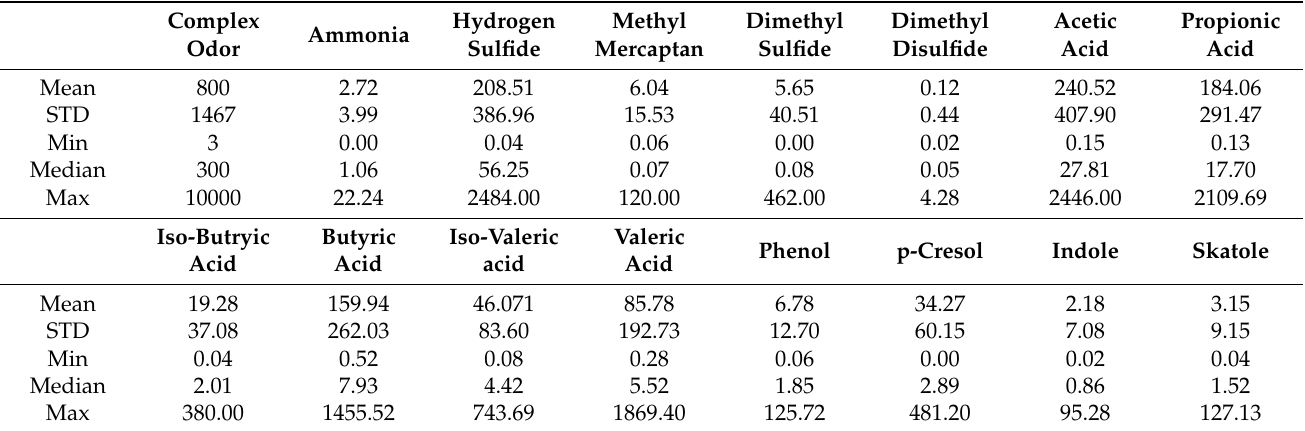
Table 4. Summary of the data after the imputation method.